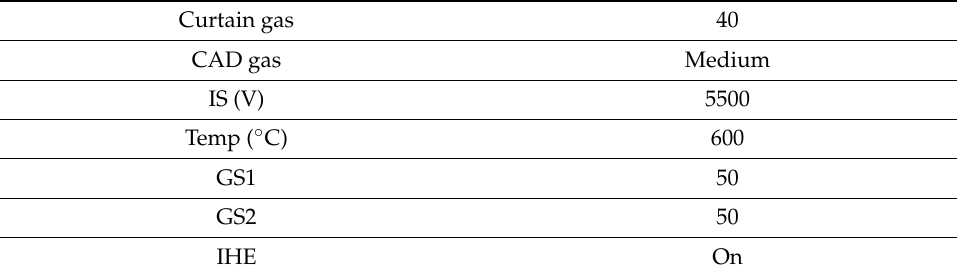
Table 5. 4000 Qtrap MS source